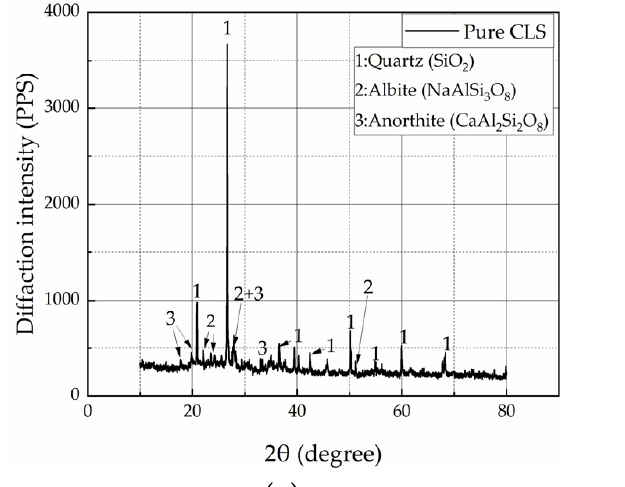
Figure 11. The XRD results of ( a ) pure CLS and ( b ) PMMRS.